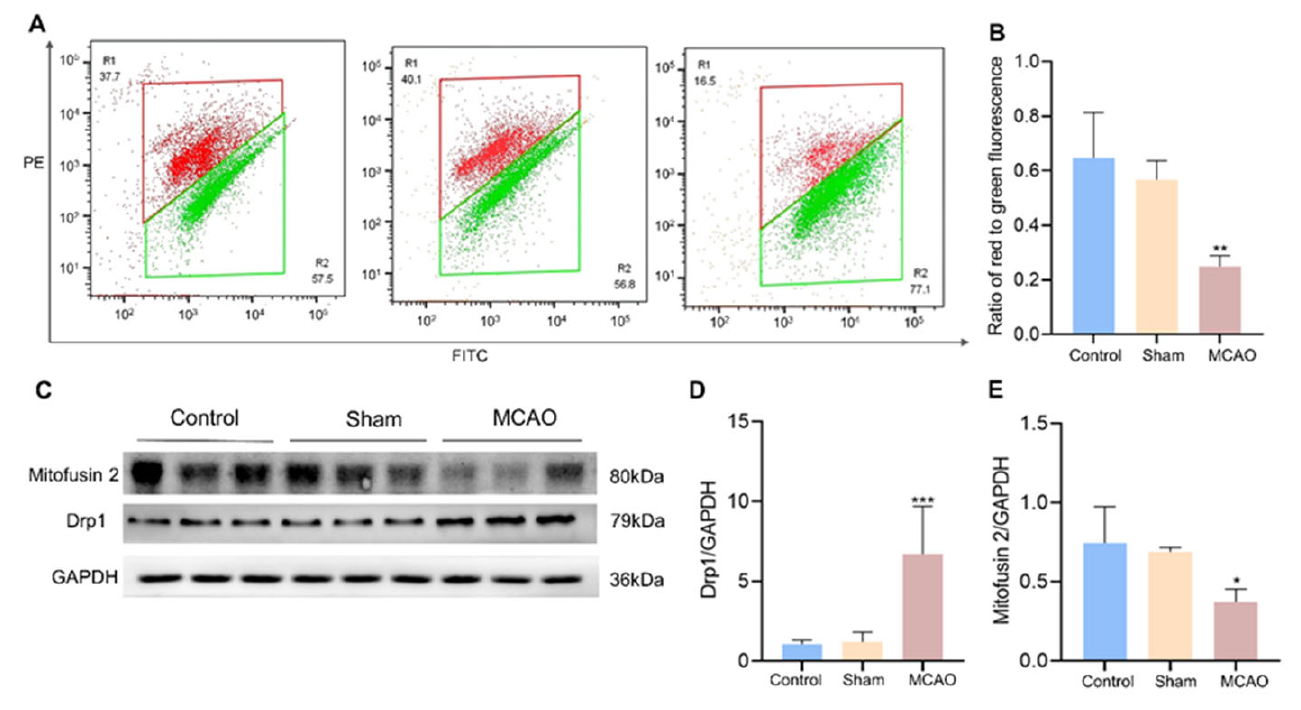
Figure 5. Effect of MCAO on mitochondrial functional impairment in rat soleus muscle. ( A ) Representative pictures and analysis of mitochondrial membrane potential changes detected by flow cytometry ( n = 4–6). ( B ) The ratio of red fluorescence to green fluorescence. ( C ) Western blot showing the protein expression levels of Mitofusin 2, DRP1, and GAPDH in soleus muscle tissue. ( D , E ) Relative protein expression for DRP1, Mitofusin 2, and GAPDH were quantified by densitometry based on immunoblot images ( n = 6–10). Results are presented as mean ± SD. * p < 0.05, ** p < 0.01, *** p < 0.001 vs. the control group and sham group.